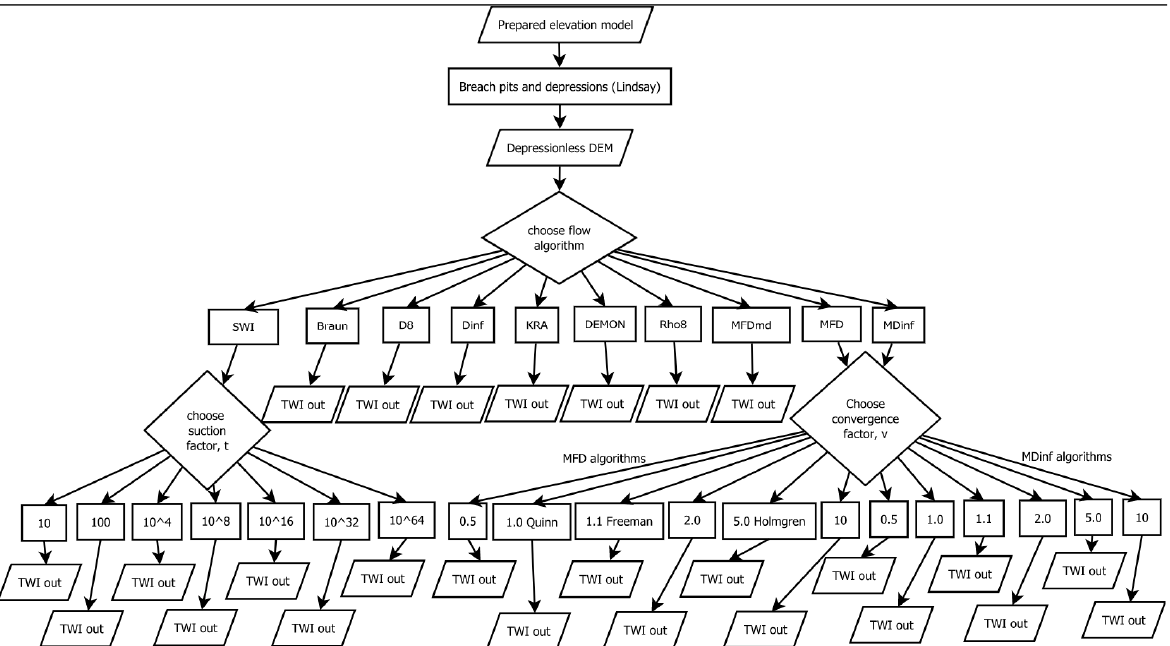
Figure 3. Process of hydrological correction, flow algorithm application, and calculation of the 26 TWI output rasters for each elevation model for the study